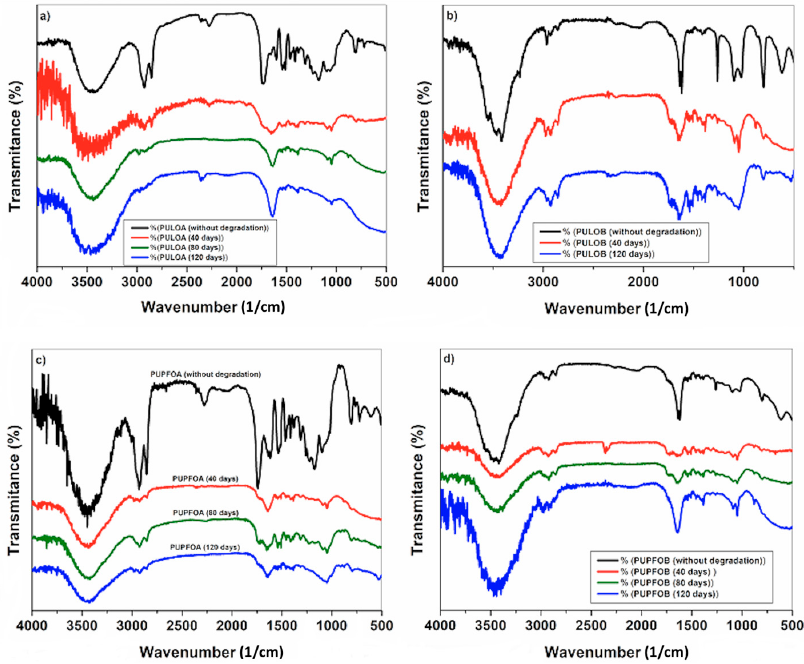
Figure 11 . FT-IR vibrational spectra of PUs subjected to soil degradation: ( a ) PULOA, ( b ) PULOB, ( c ) PUPFOA, and ( d ) PUPFOB. ( c ) PUPFOA, and ( d )